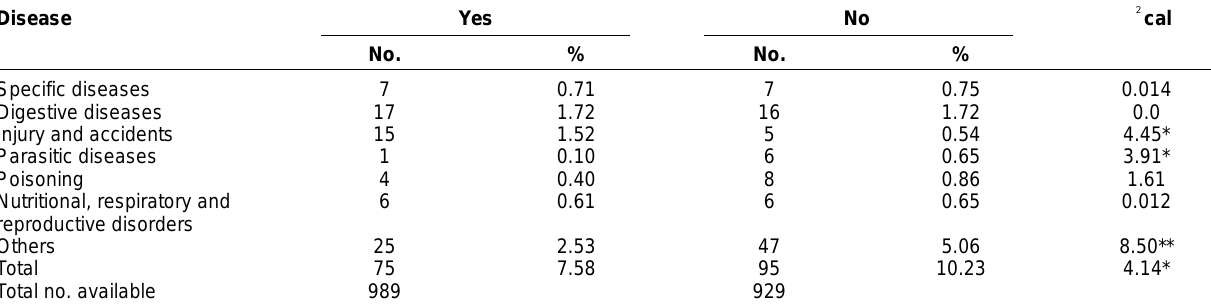
Table-2.3. Feeding management factor (Grazing) wise mortality rate in